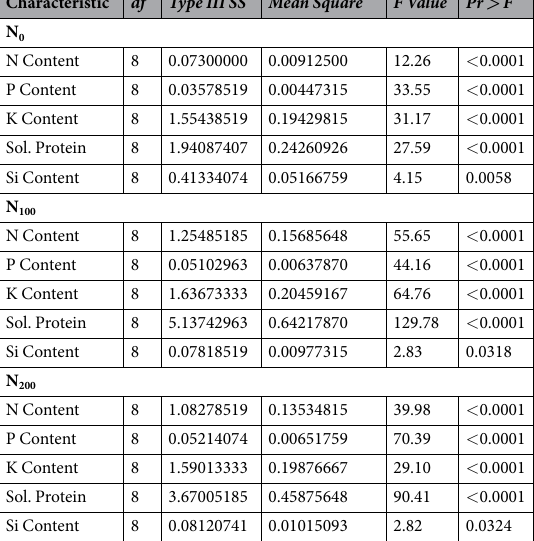
Table 1. One-way MANOVA results summary for five rice plant characteristics.